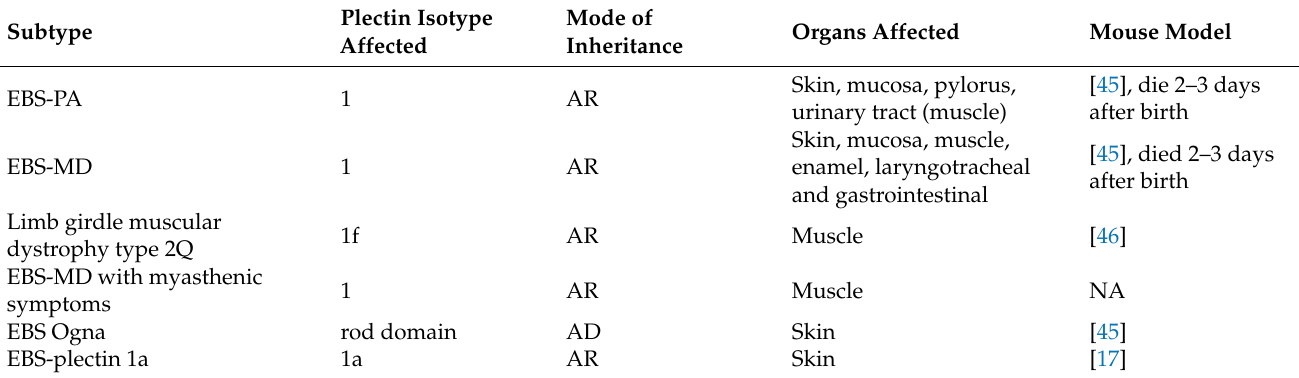
Table 1. Disorders associated with plectin